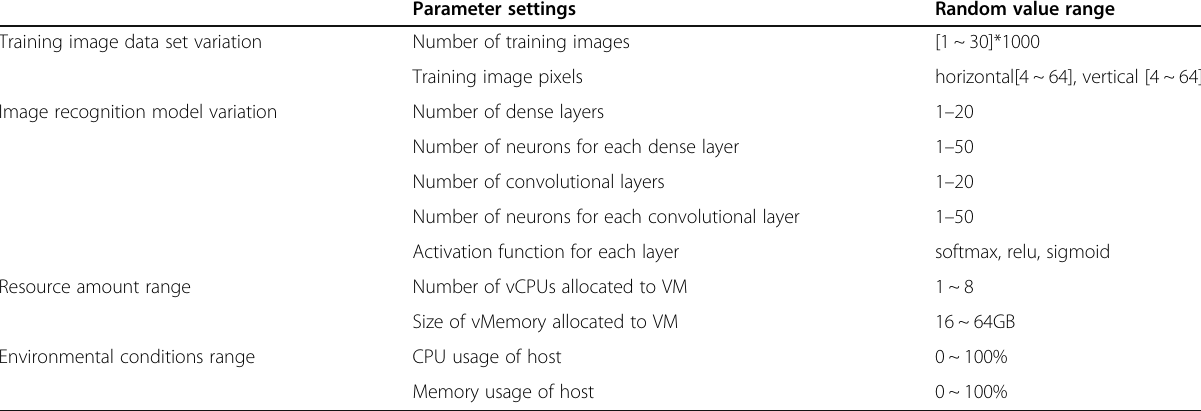
Table 5 Random parameter range of workload, resource and environmental conditions in the experiment